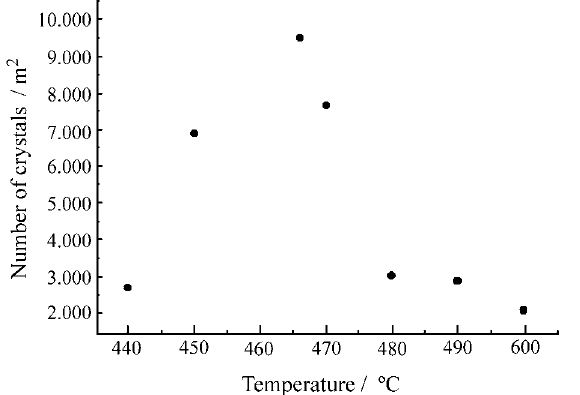
Figure 7. Number of nuclei at different temperatures after treatment at 560